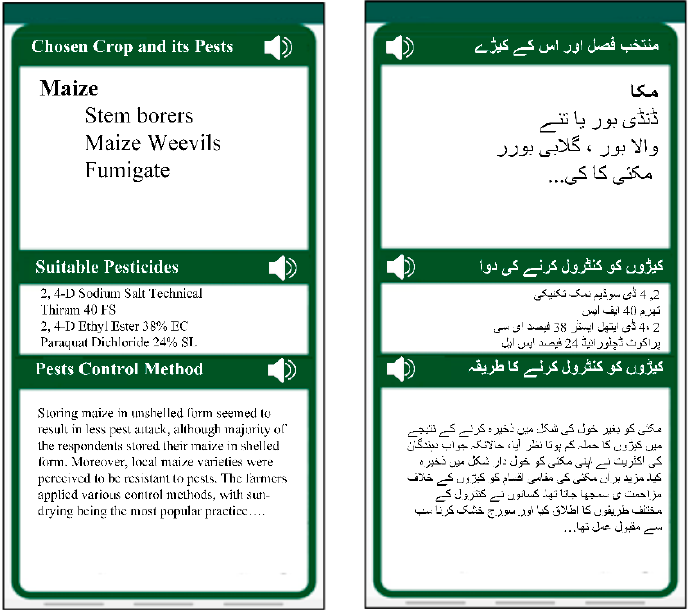
Figure 9. Pests attack control guidelines.